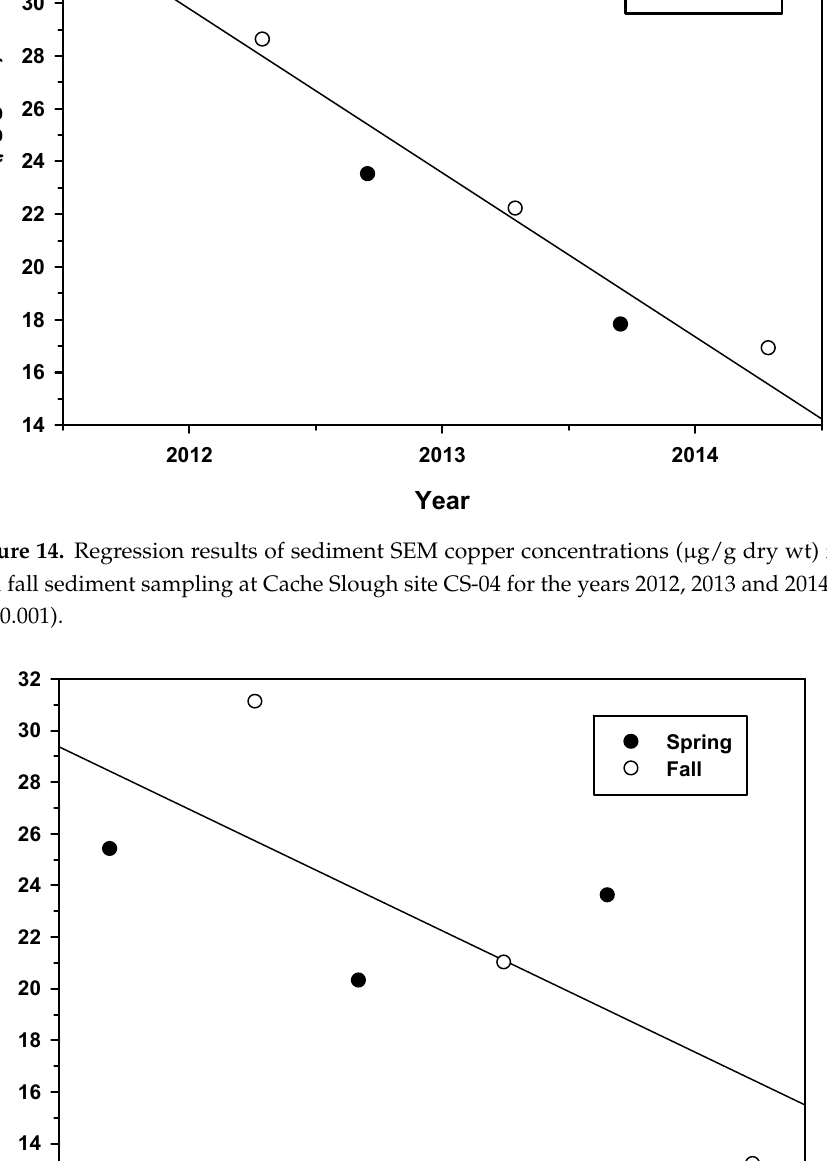
Figure 13. SEM copper concentrations (µg/g dry wt) from spring and fall sediment sampling at Cache Slough site CS-12 for the years 2012, 2013 and 2014.